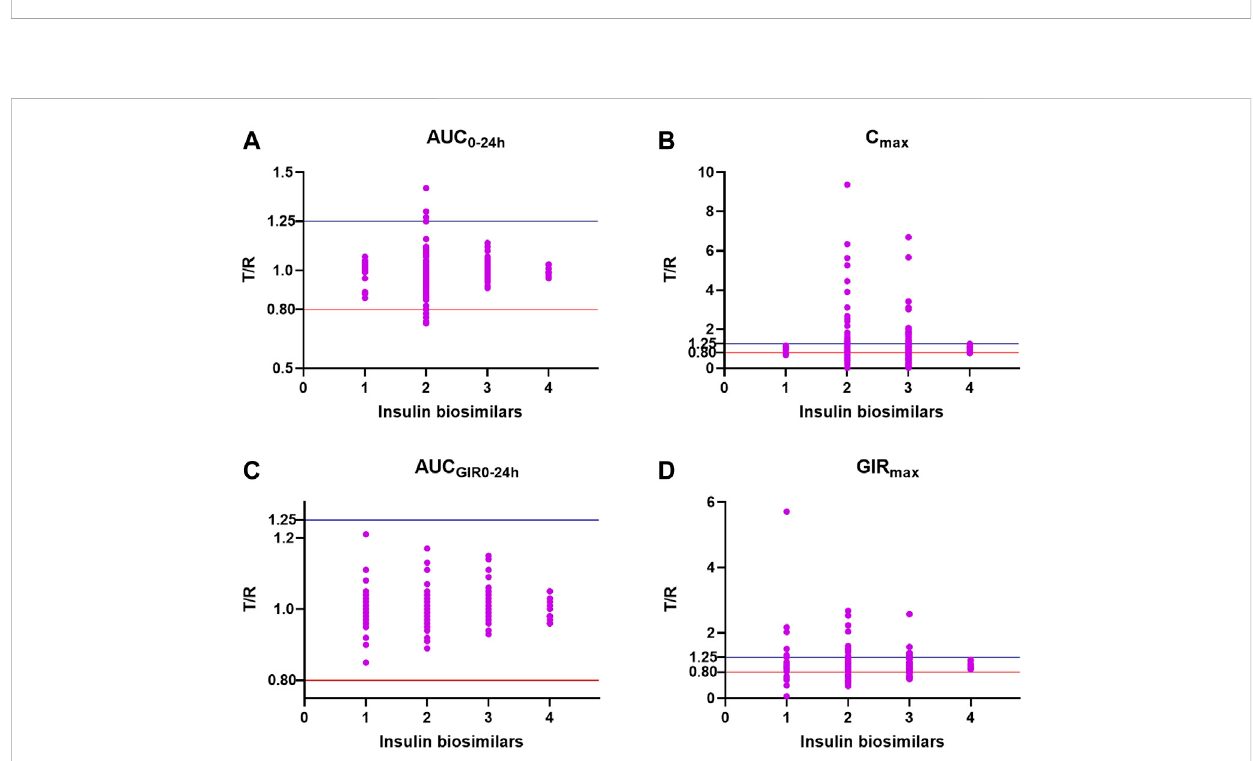
FIGURE 4 Bioequivalence evaluated in AUC 0 – 24h (A) , C max (B) , AUC GIR0 – 24h (C), and GIR max (D) . The y -axis represents T/R values, and the x -axis represents insulin biosimilars (1. insulin glargine injection; 2. insulin degludec injection; 3. insulin lispro injection 25R; 4. insulin lispro injection 50R).